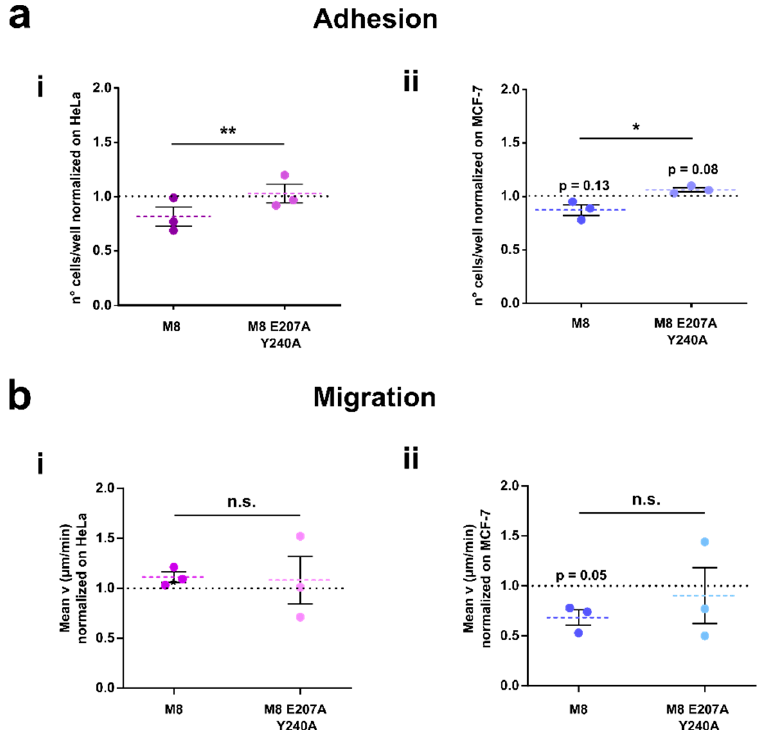
Figure 8. Validation of TRPM8 E207A Y240A on other epithelial cancer cell lines. ( a ) Quantification of adhesion assays on HeLa ( i ) and MCF-7 ( ii ) cells transfected with TRPM8 wt and TRPM8 E207A Y240A. Data are normalized on control cells (HeLa or MCF-7 cell transfected with empty vector represented by dot lines) and displayed as mean ± SEM of three independent experiments. Statistical significance versus HeLa/MCF-7 wt, *: p < 0.05; **: p < 0.01; n.s.: not significant (One sample t-test);